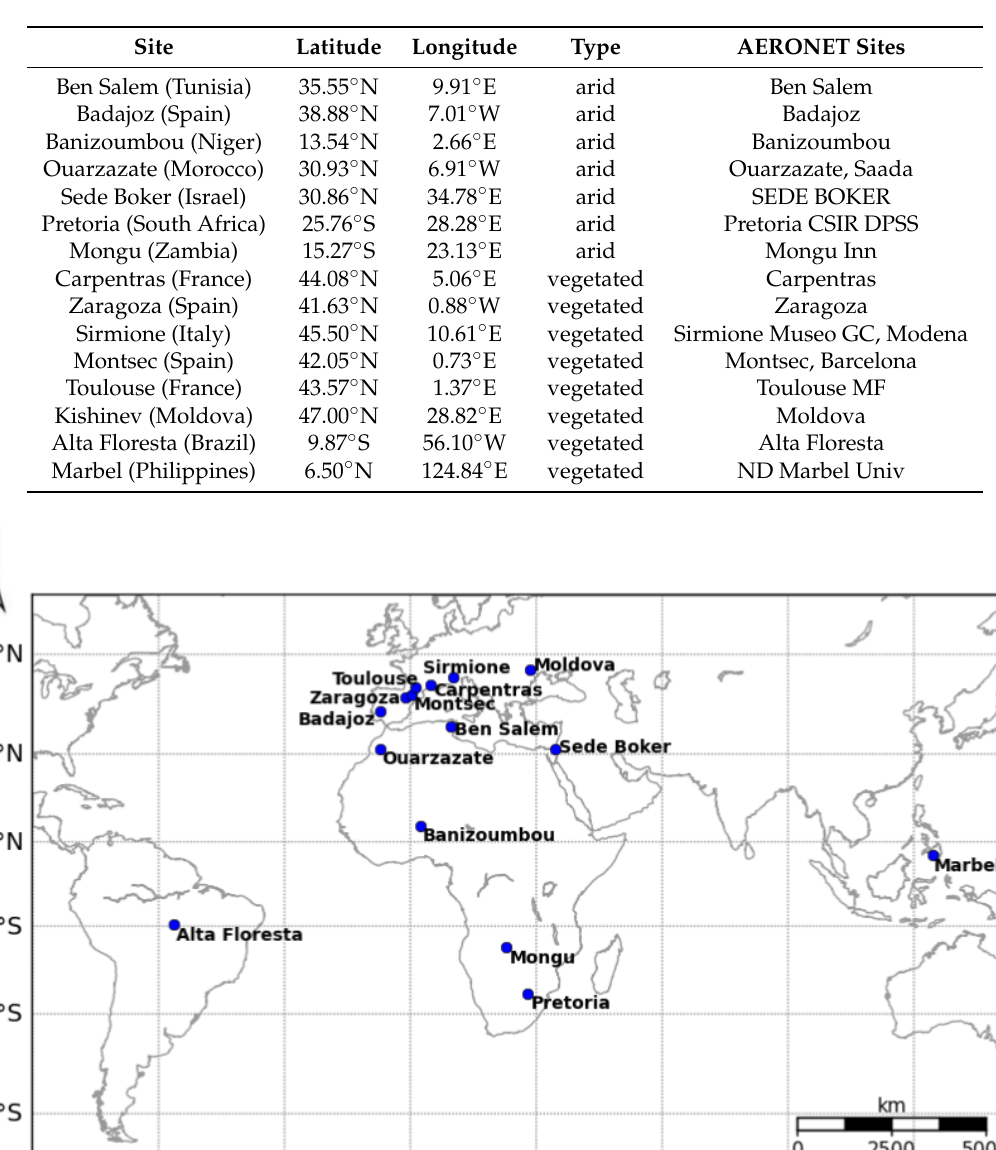
Table 3. Sites used in this study from the Aerosol Robotic Network (AERONET) [34,35] network.